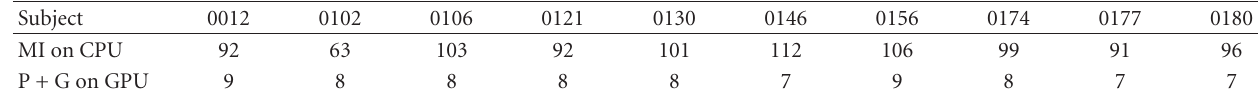
Table 4: Time elapsed, in minutes, for registration using deformable mutual information (MI) on the CPU (AMD Phenom II X4 955, 6GB DDR3 1333) and our proposed approach (P + G) on the GPU (NVIDIA GTX 260, 896 MB) with 1000 iterations of gradient